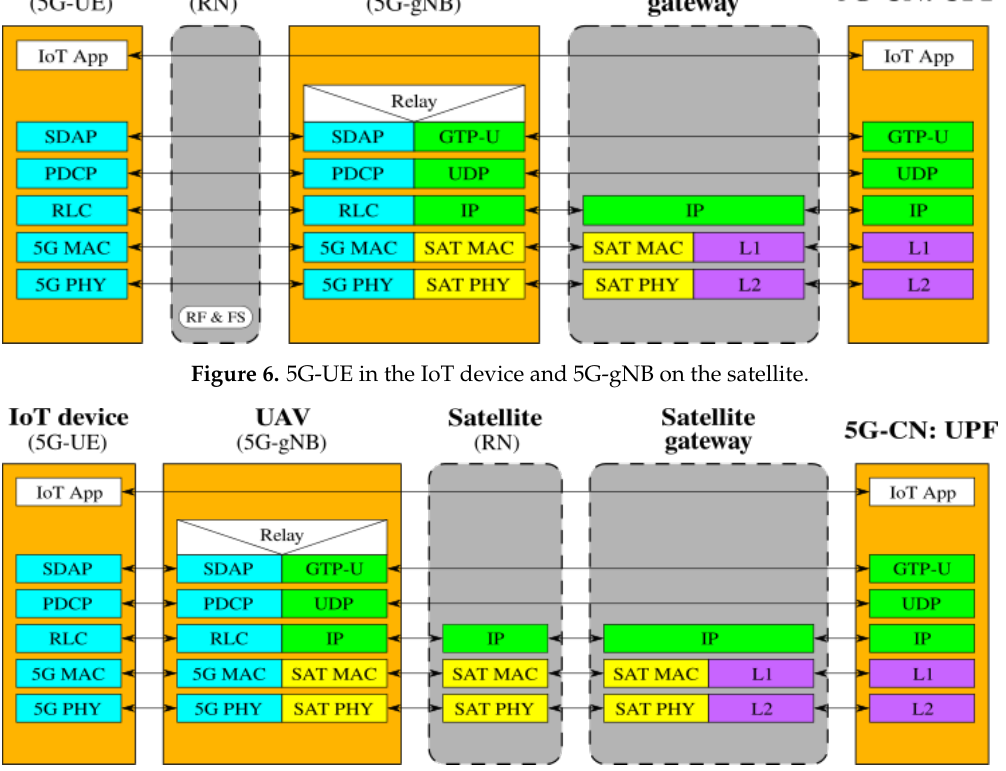
Figure 7. 5G-UE in the IoT device and 5G-gNB on the